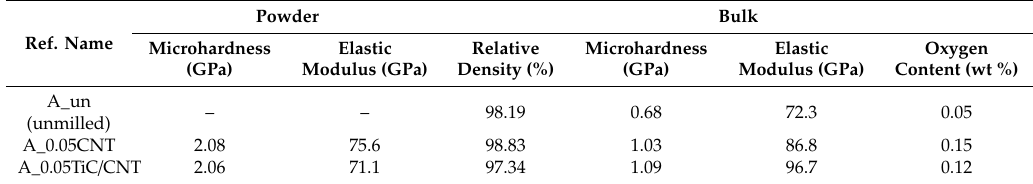
Table 2. The properties of composites in powder and bulk states.